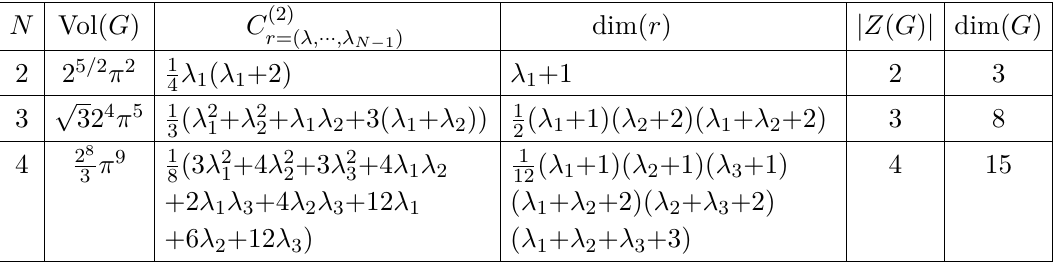
Table 1 . The table summarises all the information required for computing the probabilities in eq. (5.12) for G = SU(2) , SU(3) , SU(4)